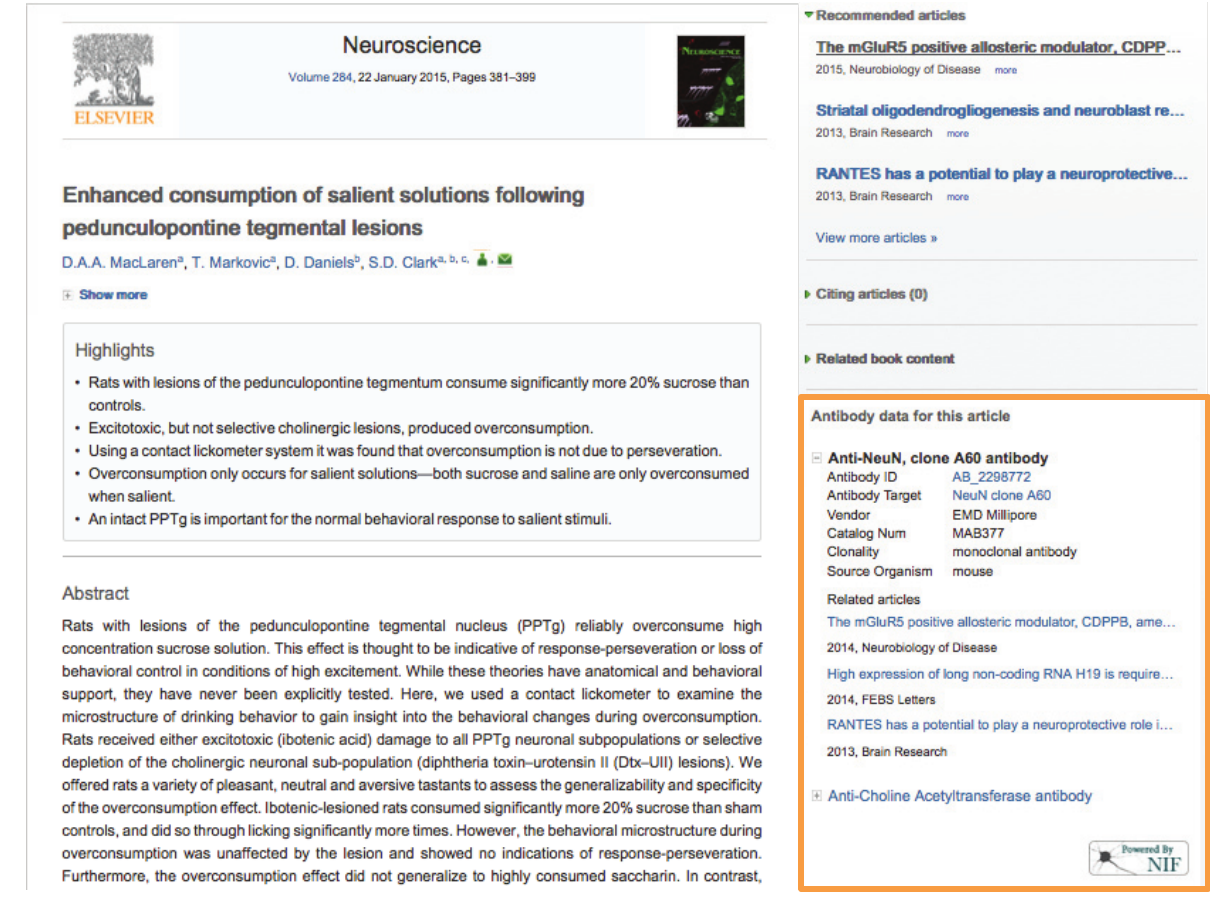
Figure 5. An exemplar third-party application using the RRID resolving service. The “Antibody data for this article” application developed by Elsevier enhances articles on ScienceDirect. The application is available in 211 articles in 19 journals (more information can be found at: